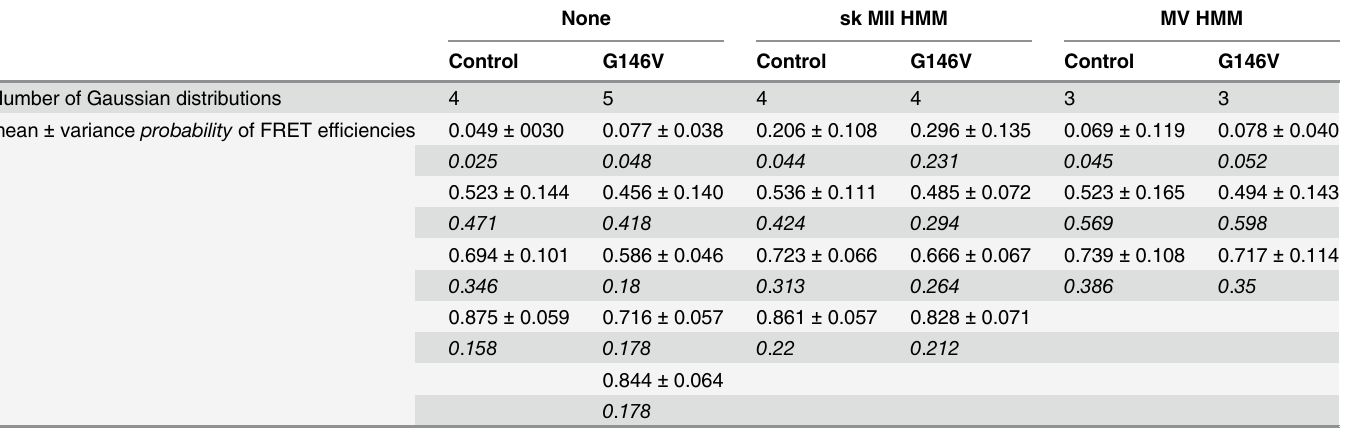
The difference in FRET distributions between control and G146V FRET actins in the pres- ence of 2.5 μ M sk MII HMM was significantly larger than in the absence (Fig 3A). A lower FRET state of G146V FRET actin, which had a mean FRET efficiency of 0.30 (Table 2), ap- peared. We observed this state with control FRET actin as well, but its population was much smaller than that of G146V FRET actin. Furthermore, changes in FRET distribution induced by sk MII HMM were different between control and G146V FRET actins. Mean of FRET Table 2. Parameters of the FRET efficiencies obtained by Gaussian fitting. None sk MII HMM MV HMM Control G146V Control G146V Control